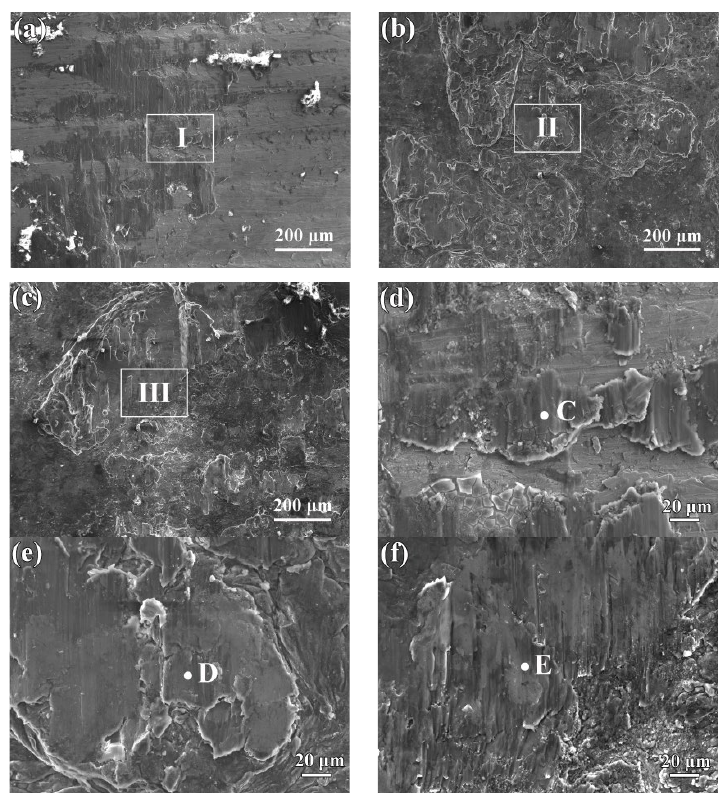
Figure 11. SEM fractographs on the Q235 side of the interface for the ( a ) AZ63/Q235, ( b ) AZ63/galvanized Q235, and ( c ) AZ63/galvanized Q235 + T6 push-out samples; ( d – f ) magnified image of the region I, II, and III, respectively. Table 5. EDS results taken from points C, D, and E in Figure 11 (at.%).